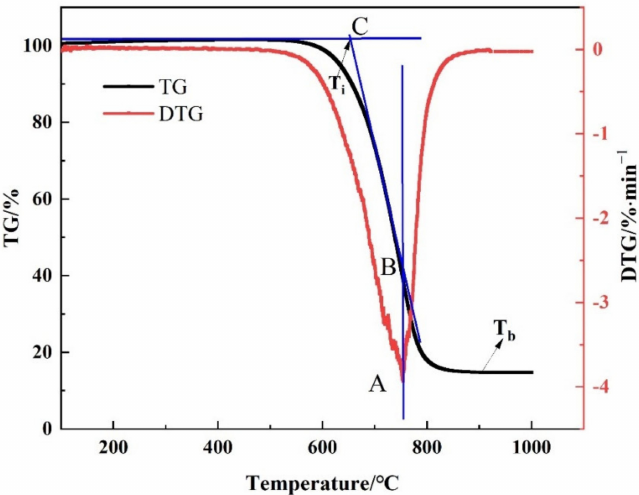
Figure 1. Schematic diagram for the combustion characteristic temperature of coke (T i is the ignition temperature, T b is the burnout temperature, A is the peak point of the DTG curve, B is the point with the fastest weight loss rate, C is the intersection of the tangent line passing through point B and the horizontal line where weightlessness